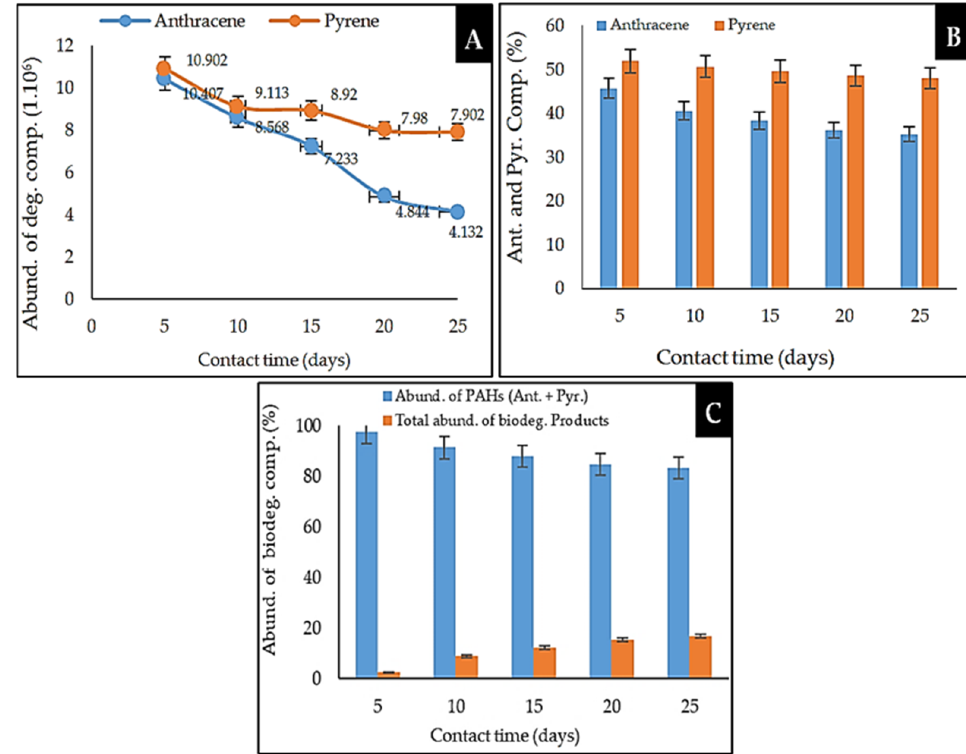
Figure 6. Biodegradation performance of anthracene and pyrene by consortium of marine sponge symbiotic bacteria as a function of contact time. ( A ) Abundance of anthracene and pyrene corre- sponding to the peak height obtained in the GC–MS analysis; ( B ) reduction in anthracene and pyrene components; ( C ) percentage abundance of anthracene and pyrene.